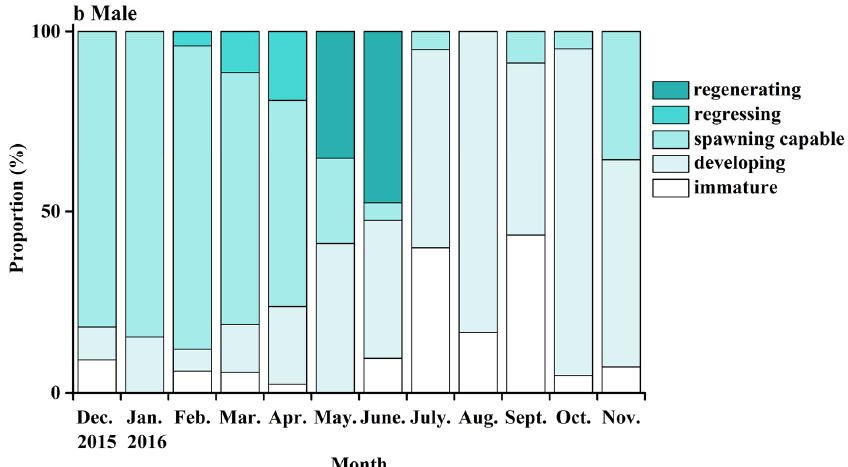
Figure 6. Monthly proportion distribution of gonadal development stages of mature individuals for females (( a ), standard length > 82.4 mm) and males (( b ), standard length > 55.4 mm) of G. tibetana in